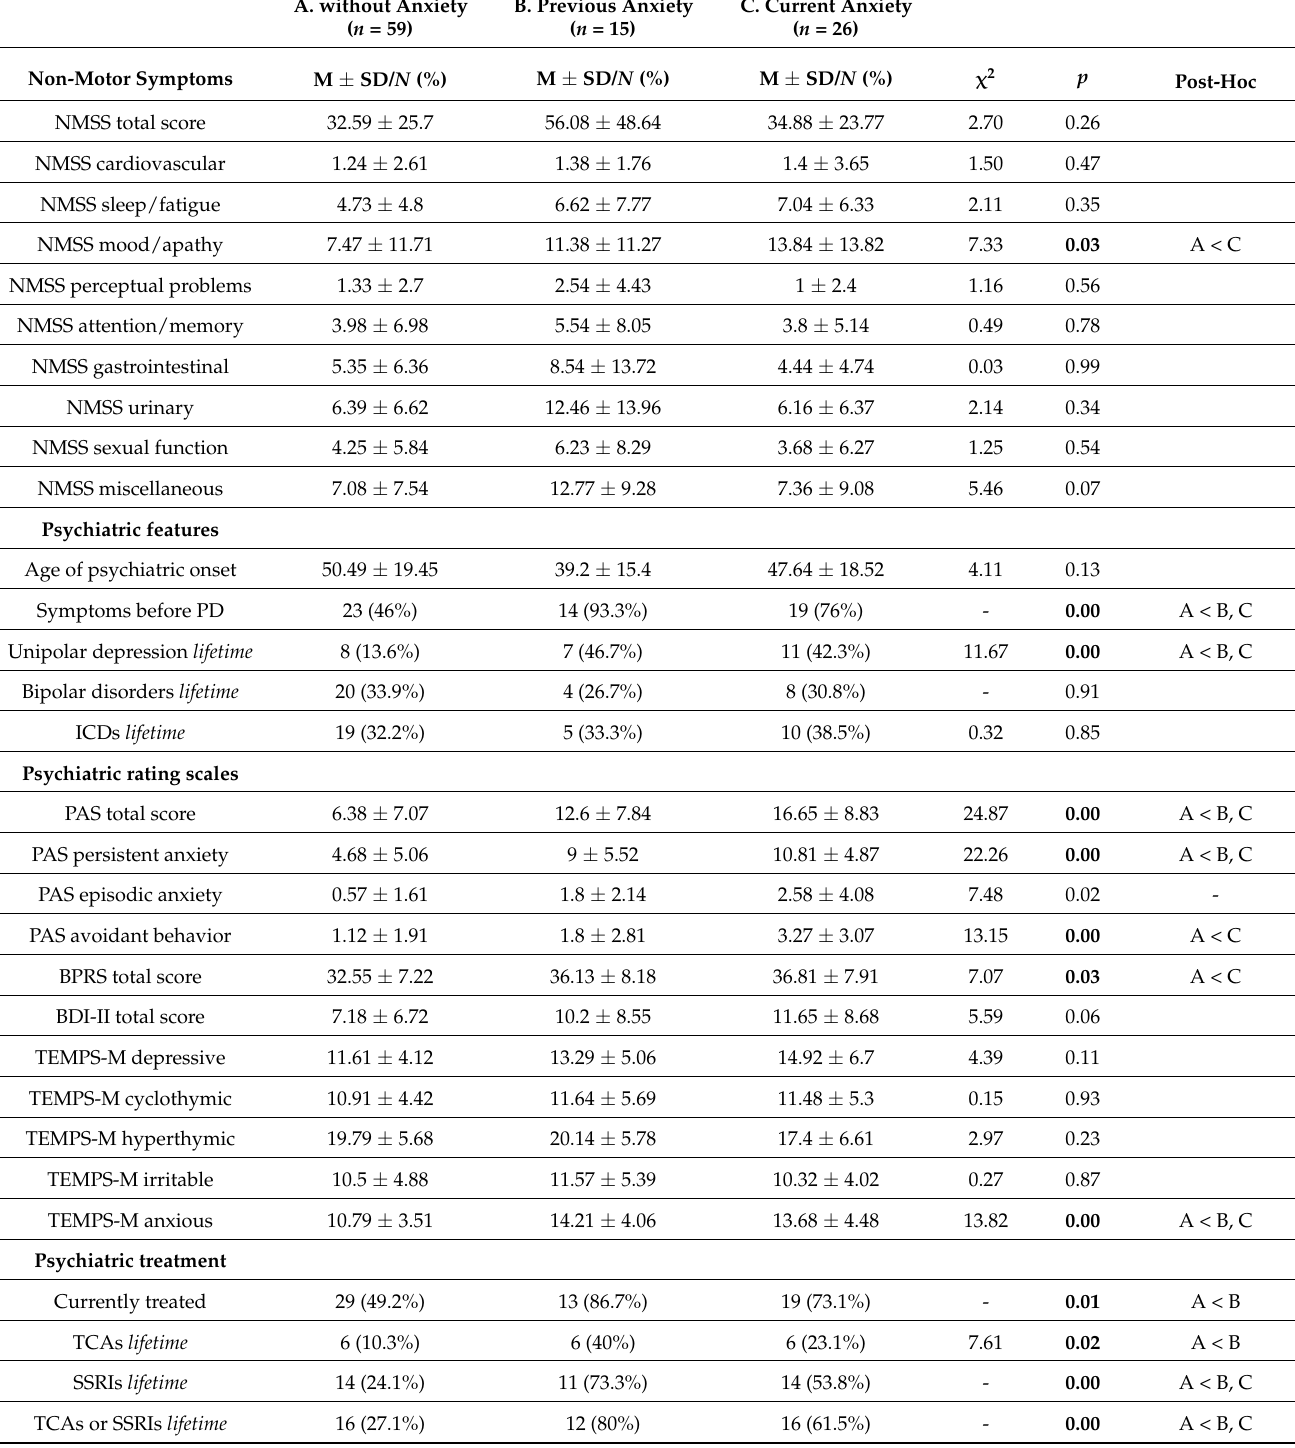
Table 2. Differences in non-motor symptoms and psychiatric features among PD patients without anxiety disorders, with previous or with current anxiety